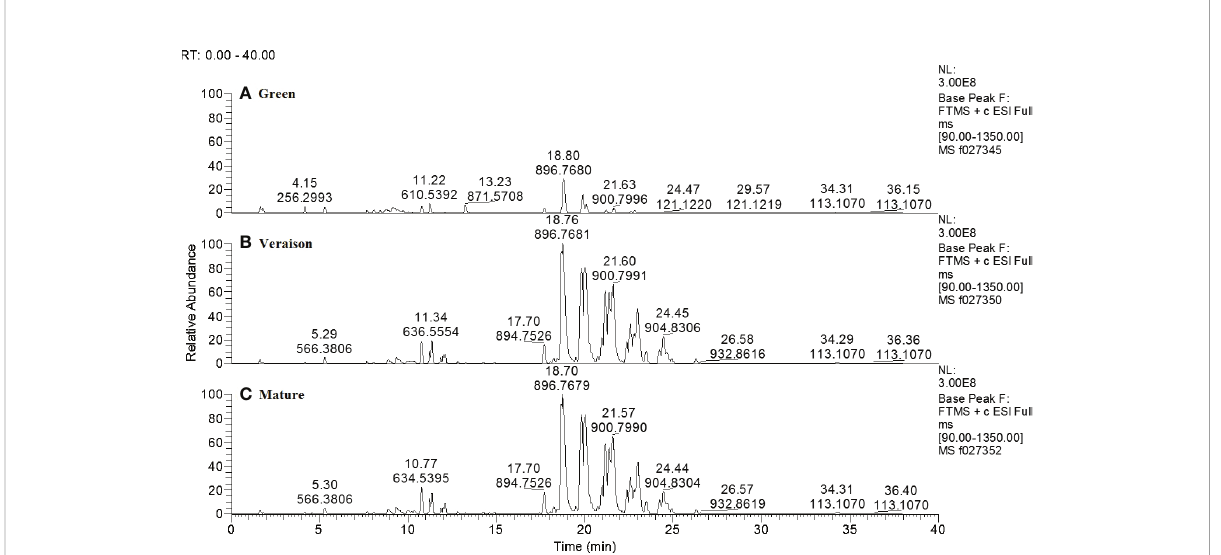
FIGURE 1 Representative LCMS chromatograms of lipid-soluble compounds in seeds from LL-grown Alvarinho berries at different developmental stages: green (A) , veraison (B) and mature (C) . Numbers above peaks represent, from top to bottom, the retention time (min) and accurate mass (m/z; positive ionization mode), respectively. The three chromatograms are in the same Y-scale. Annotations of compounds, if known, are provided in Supplementary Table 1.